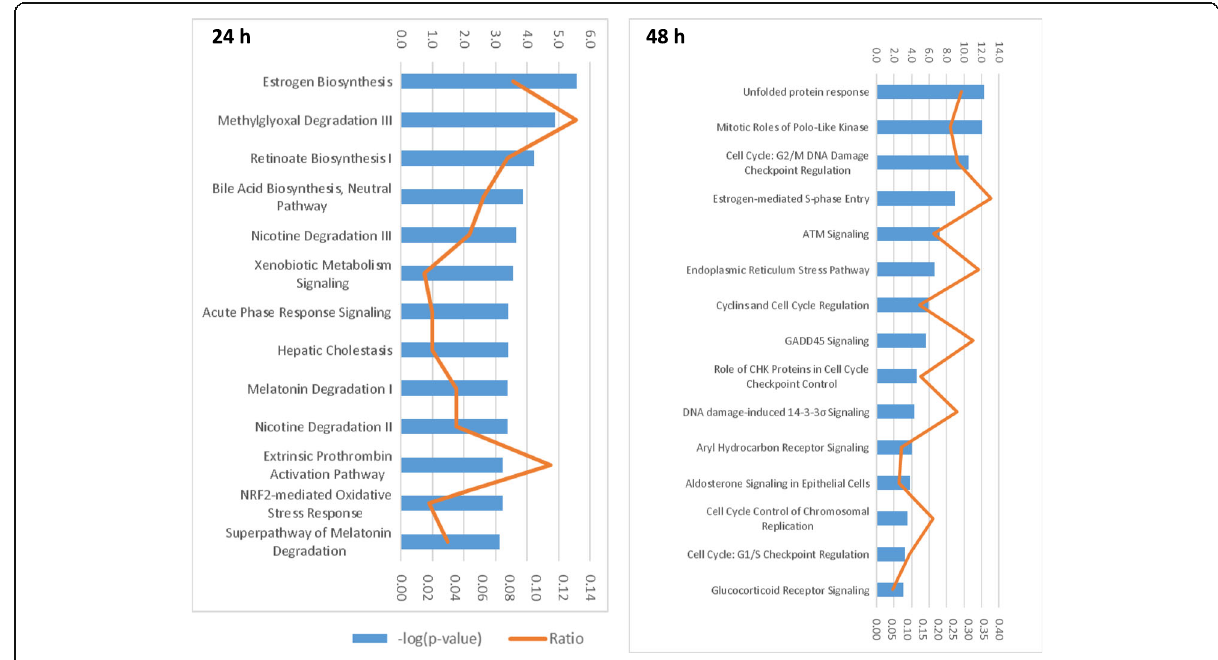
Fig. 1 Top IPA canonical pathways identified at 24 h and 48 h after NDL treatment of MCF-7 cells ( p ≤ 0.001)